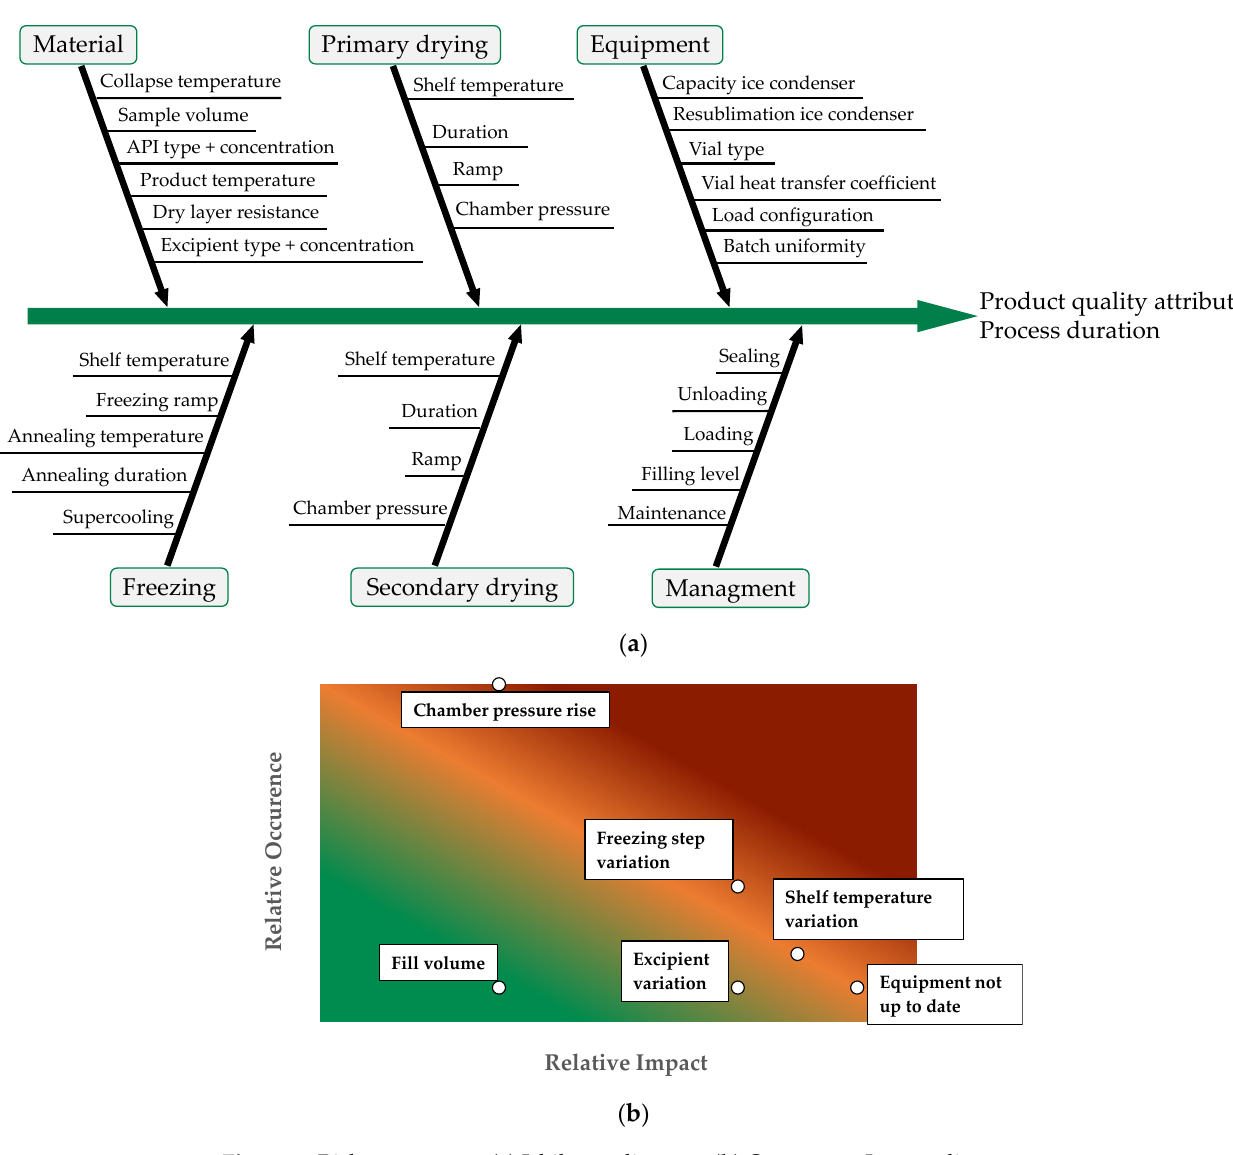
Figure 2. Risk assessment: ( a ) Ishikawa diagram; ( b ) Occurrence Impact diagram. The failure mode effects analysis (FMEA) is based on prior experience. The derived scoring for the Occurrence Impact diagram is shown in Table 1. Table 1. QbD risk assessment: FMEA.